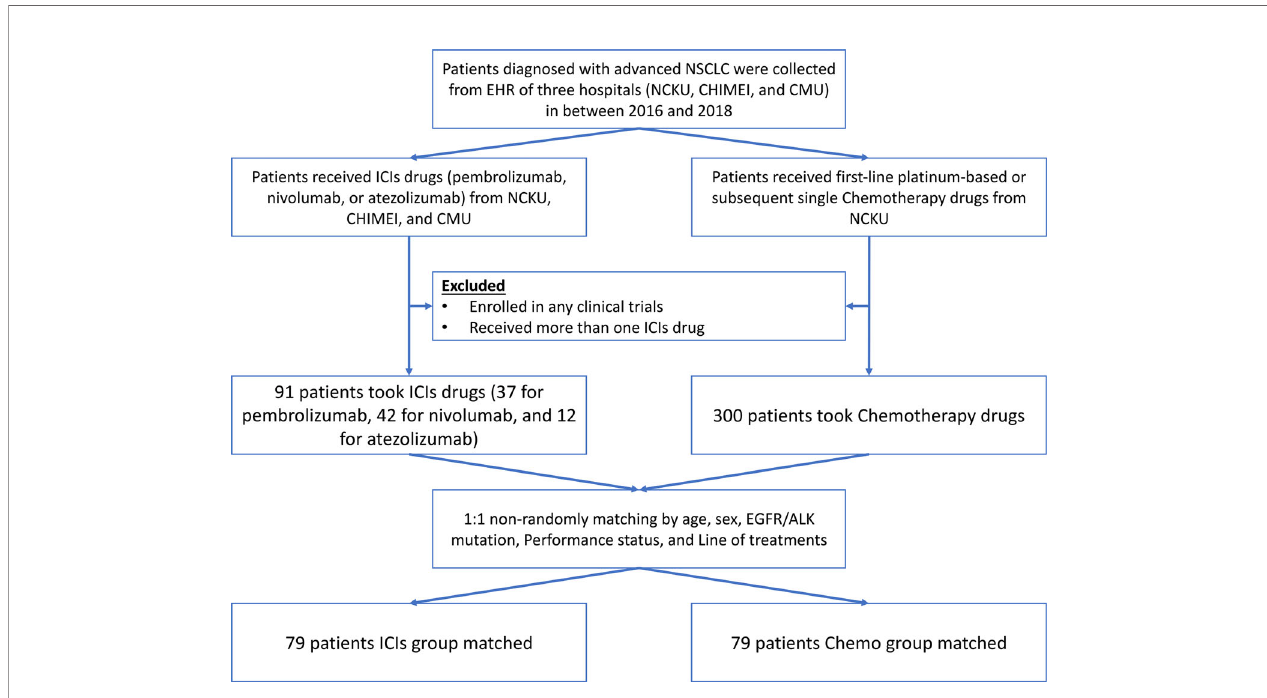
FIGURE 1 | Enrollment process of the study